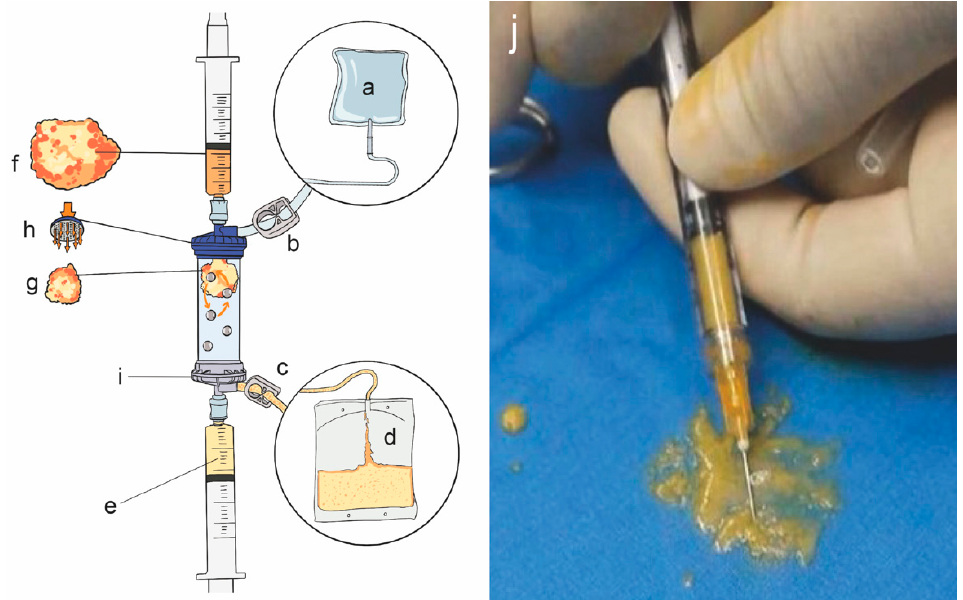
Figure 1. Lipogems ® device and autologous micro-fragmented adipose tissue. ( a ): Physiological sa- line bag (3–5 L); ( b ): inlet clamp; ( c ): outlet clamp; ( d ): waste bag: collection of oils and blood